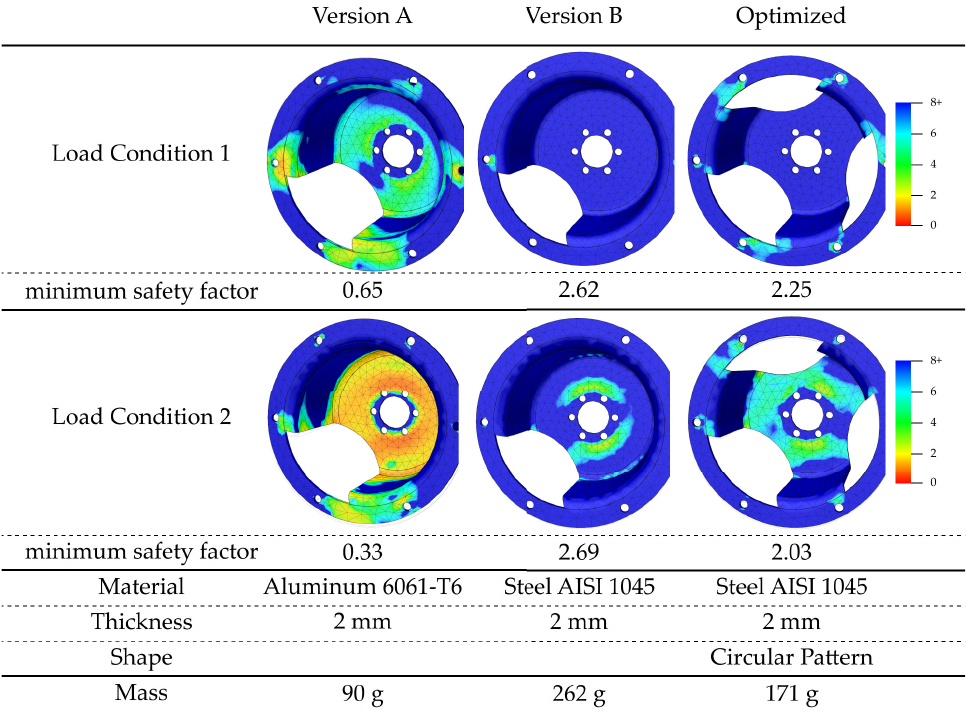
Figure 13. Optimization process of hip connector